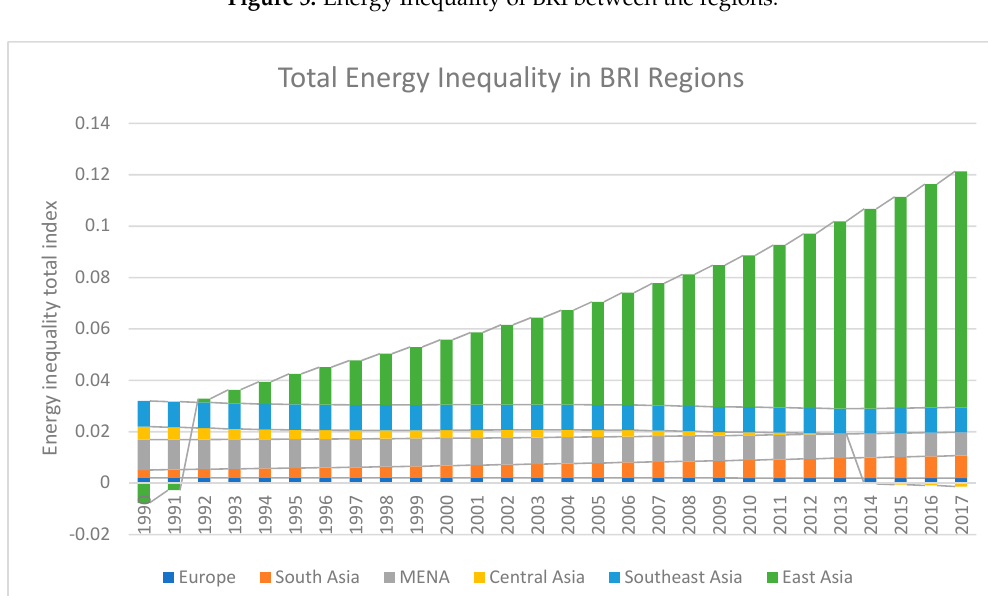
Figure 6. Total Energy Inequality in BRI regions.